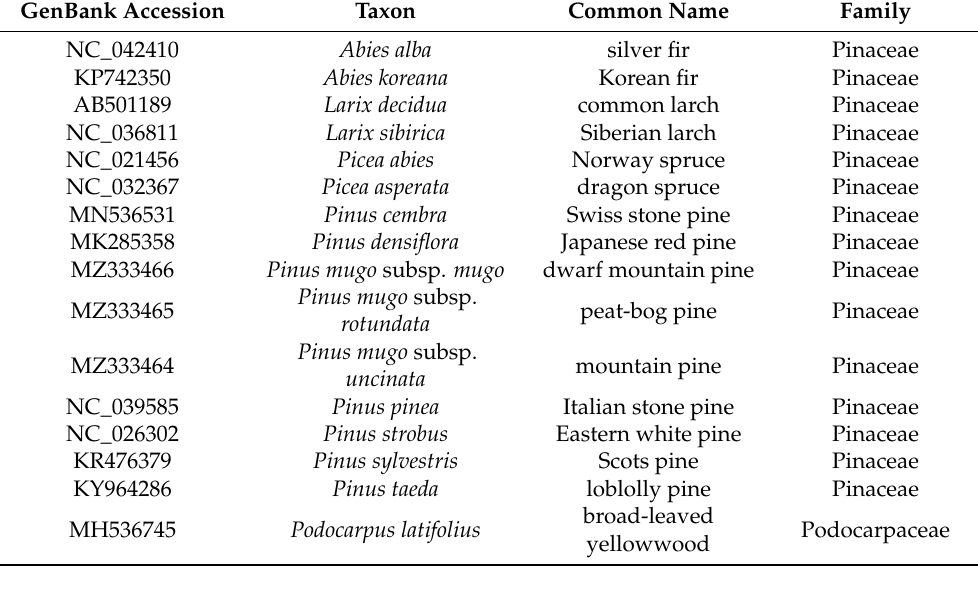
Table 4. GenBank information on complete chloroplast genomes of conifer taxa used in phylogenetic analyses in this study.